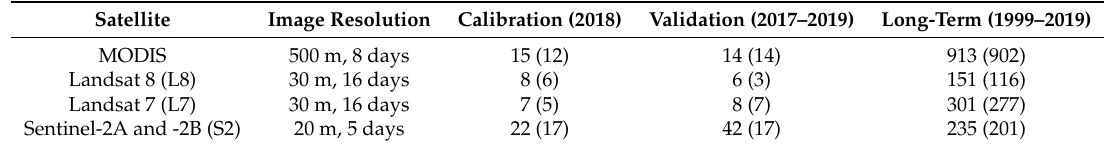
Table 1. Number of available images exploited over each period per satellite sensor. In brackets, the number of images kept after filtering for